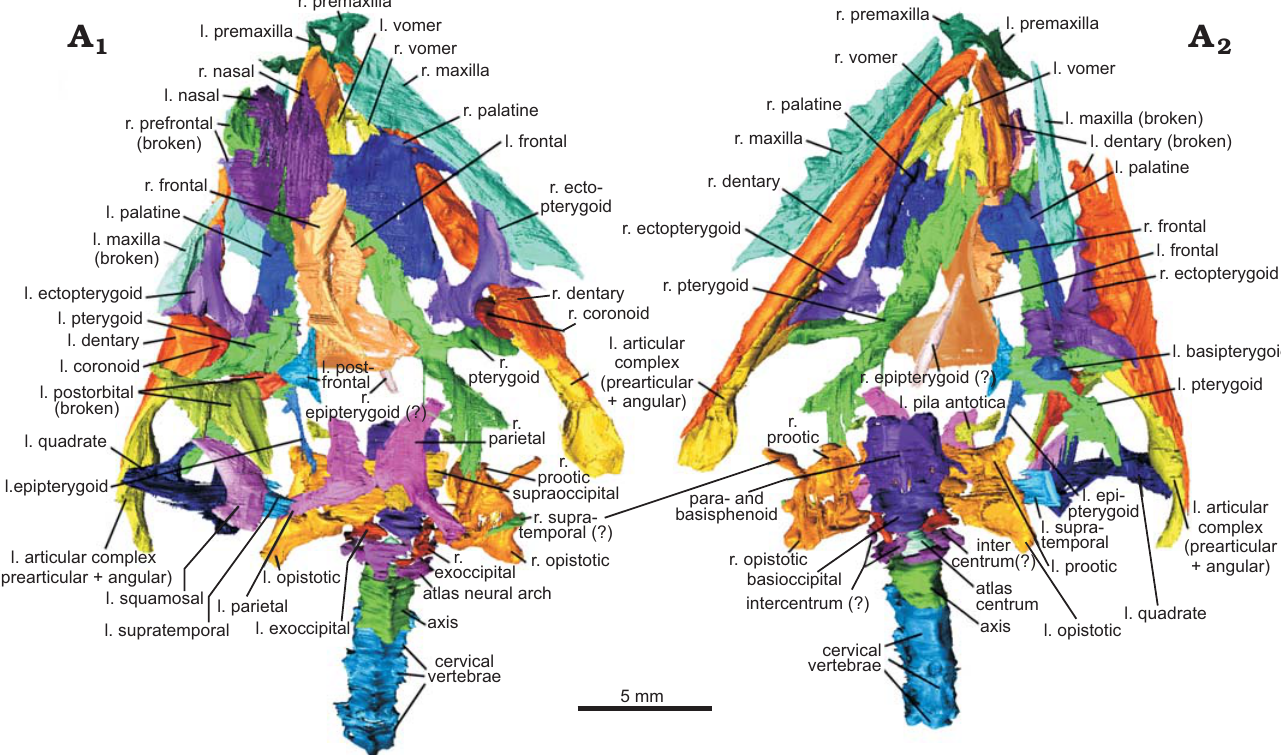
Fig. 4. The resegmented bones of lepidosaur rynchocephalian Clevosaurus cambrica Keeble, Whiteside, and Benton, 2018 (NHMUK PV R37014) from Late Triassic, Pant-y-ffynnon, Wales, UK; in dorsal (A 1 ) and ventral (A 2 ) views. Abbreviations: l., left; r.,